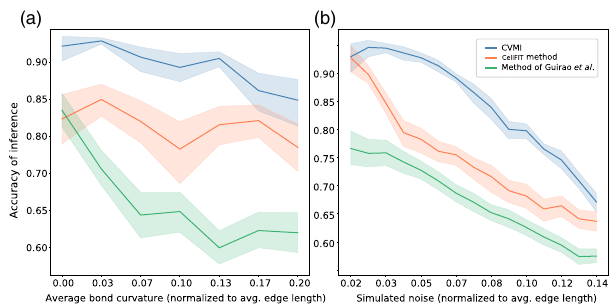
FIG. 9. Correlation between inferred tensions and pressures against the known synthetic values for three mechanical inference schemas — CVMI (blue), our implementation of the C ell FIT method [35] (orange), and the inverse used within Ref. [32] (green) — as a function of the contribution of pressure to mechanical balance (a) and the strength of random perturbations to vertex position (b). Panel (a) represents a simulated lattice with constant noise of 0.03 (strength of perturbation is normalized to the average edge length). Similarly, panel (b) is taken at a finite average pressure differential of 0.03 (average ratio of edge length to radius of curvature). All algorithms were run on the same synthetic datasets. Each curve depicts the mean and variance of 100 networks of size ∼ 120 cells generated with equivalent parameters as described in the